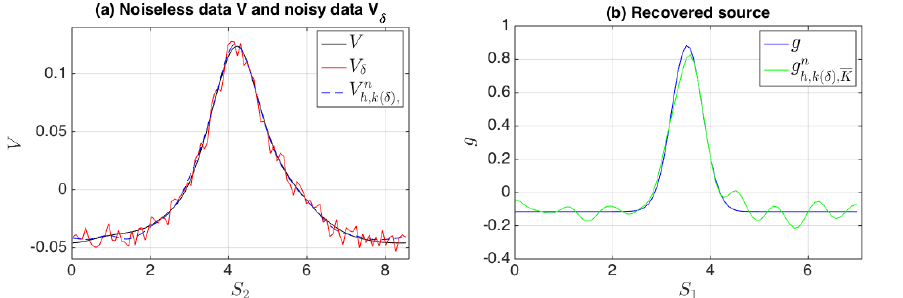
Figure 8. ( a ) Plots of exact data V (black), data with error V δ (red), and recovered data V n (blue), for δ = 0.1. ( b ) Plots of exact source g (blue) and recovered source g n corresponding to data with noise V δ using mesh M 1 of irregular region Ω